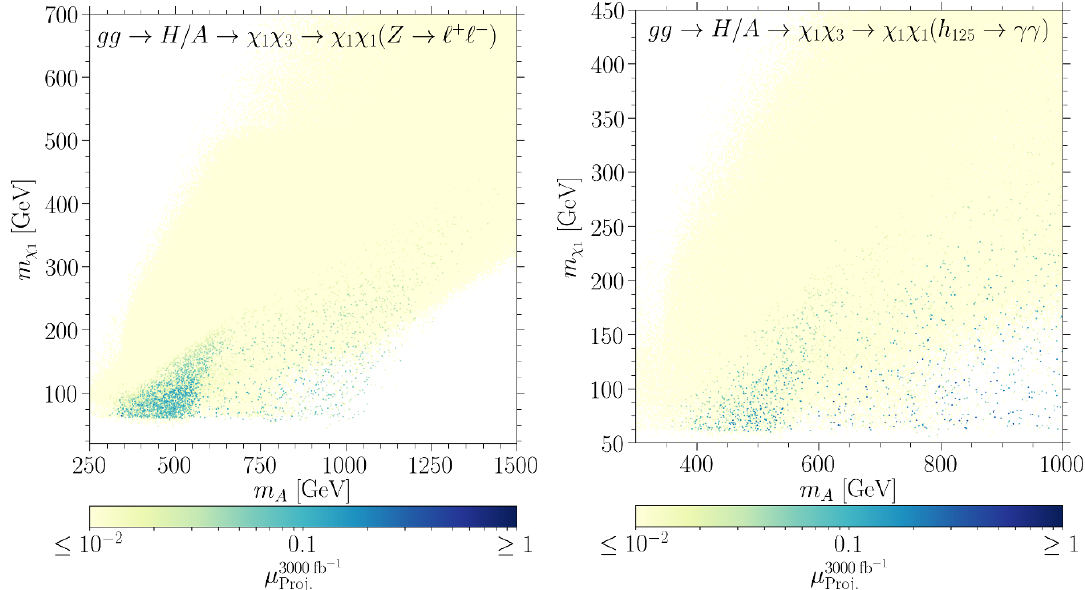
Figure 11 . Same as (cid:12)gure 6, but for the mono- Z (left) and mono-Higgs (right) (cid:12)nal states arising through decays of the parent heavy Higgs into a pair of neutralinos where one of the neutralinos subsequently radiates o(cid:11) a Z or a Higgs, cf. diagram (c) in (cid:12)gure